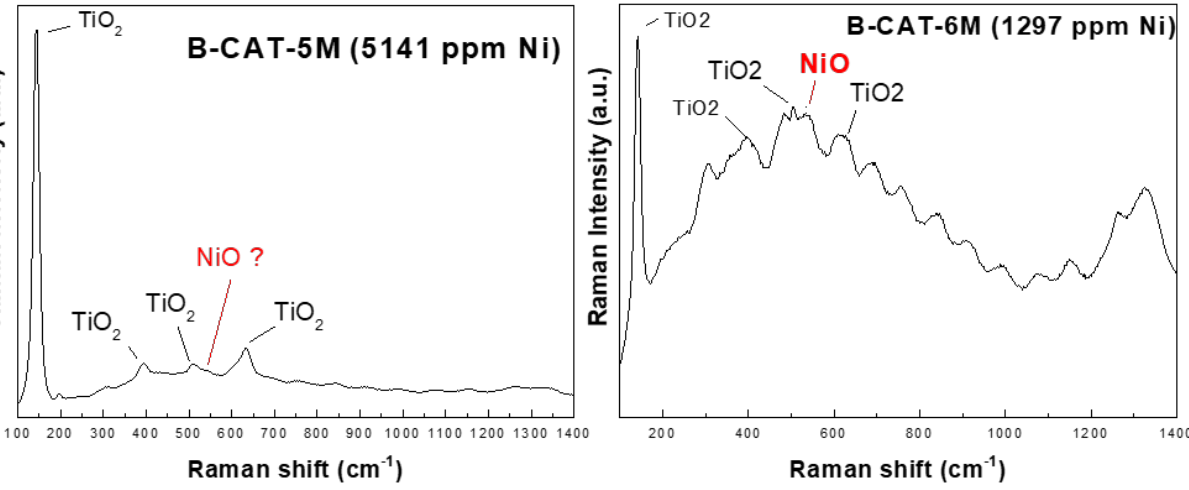
Figure 14. Raman spectra of equilibrium FCC catalysts (Ecats): B-CAT-5M (5141 ppm Ni) and B-CAT-6M (1297 ppm Ni).